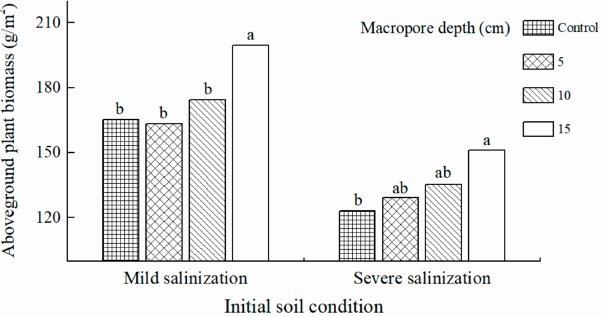
Figure 6. Aboveground plant biomass of alfalfa under different macropore depth treatments for artificial macropores with sandy fillings (AMSF) method. Control means soils without macropore. Mean values within same initial soil condition followed by different letters are significantly different ( p =